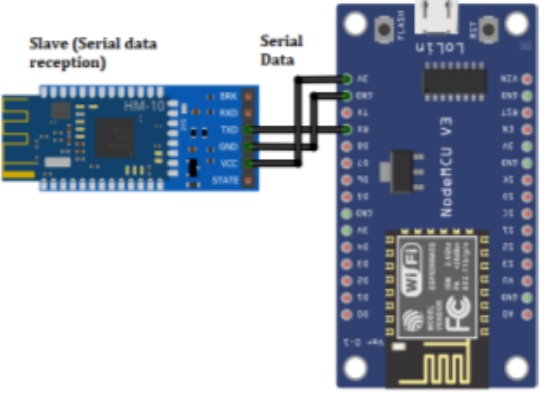
Figure 10. Interfaced sensors with their connecting interfaces with Arduino.